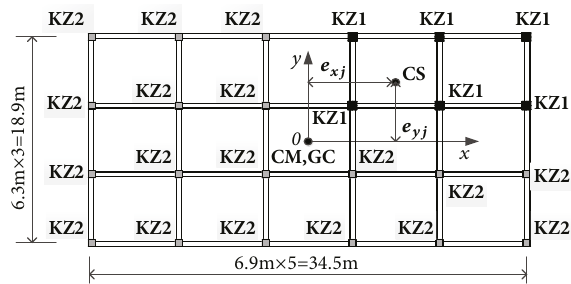
Figure 1: Plan view of structure investigated.